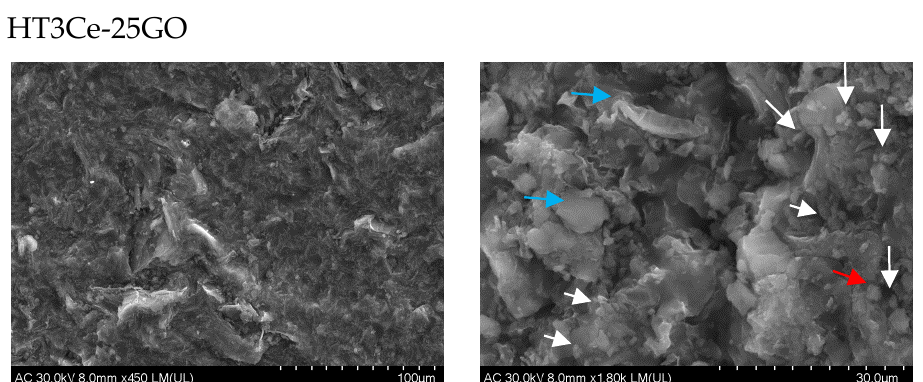
Figure 5. SEM images of the HT3Ce-xGO composites (left: low magnification; right: high magnifi- cation), with different aspects of the grain surfaces indicating polymorphic (blue arrows), irregular “ovoidal” (white arrows), or cubic (red arrows) structures.